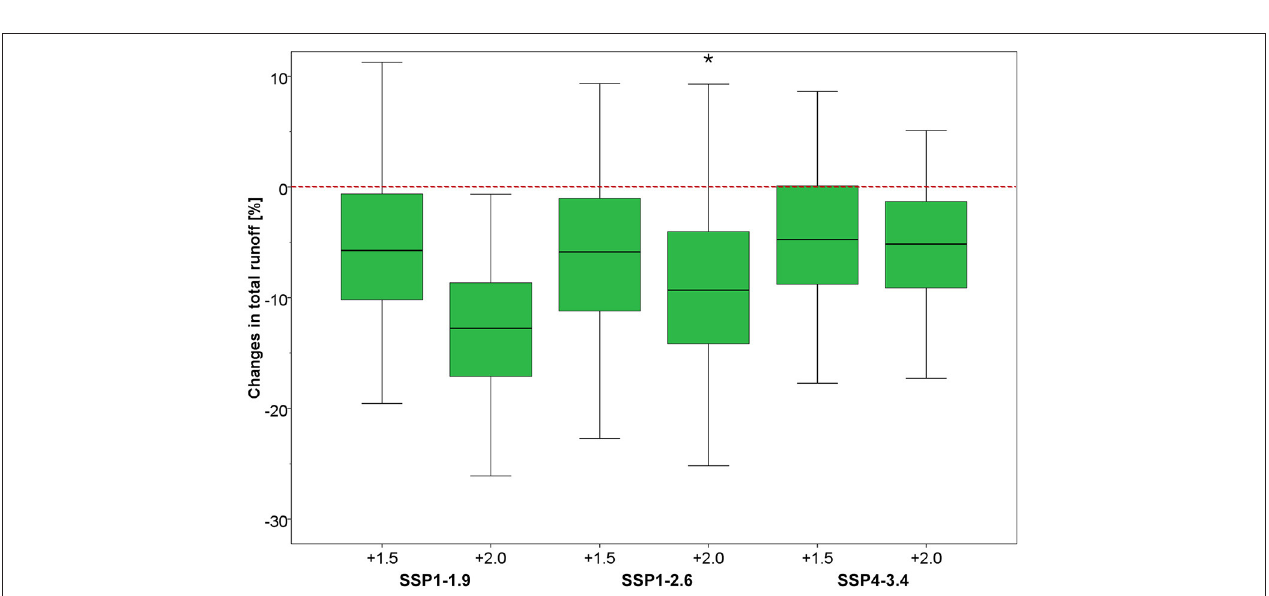
FIGURE 7 | Boxplot of the projected changes in total runoff (mrro), expressed as the percentage of change relative to the 1981–2010 baseline period, over the Andes domain. The changes are based on the periods where the temperature anomaly is projected to reach 1.5 and 2 ◦ C above preindustrial levels, considering the SSP1-1.9, SSP1-2.6, and SSP4-3.4 scenarios. Each boxplot shows the median and first and third quartiles, while the whiskers extend to the data values that are 1.5 times the interquartile range above or below the quartiles. Outliers are represented by